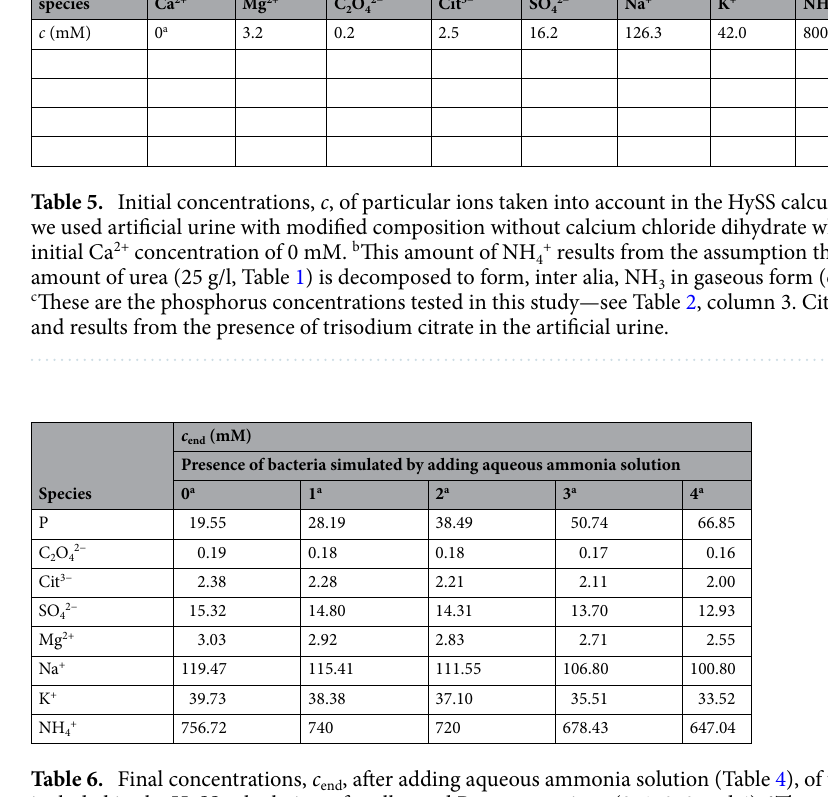
Table 6. Final concentrations, c end , after adding aqueous ammonia solution (Table 4), of the individual ions included in the HySS calculations, for all tested P concentrations (0, 1, 2, 3 and 4). a These P concentrations (0—baseline and 1–4 tested concentrations) are investigated in this article. The calculations took into account the addition of an aqueous ammonia solution (Table 4), which resulted in a slight change in the molar concentrations of individual ions compared to the initial ones (Table